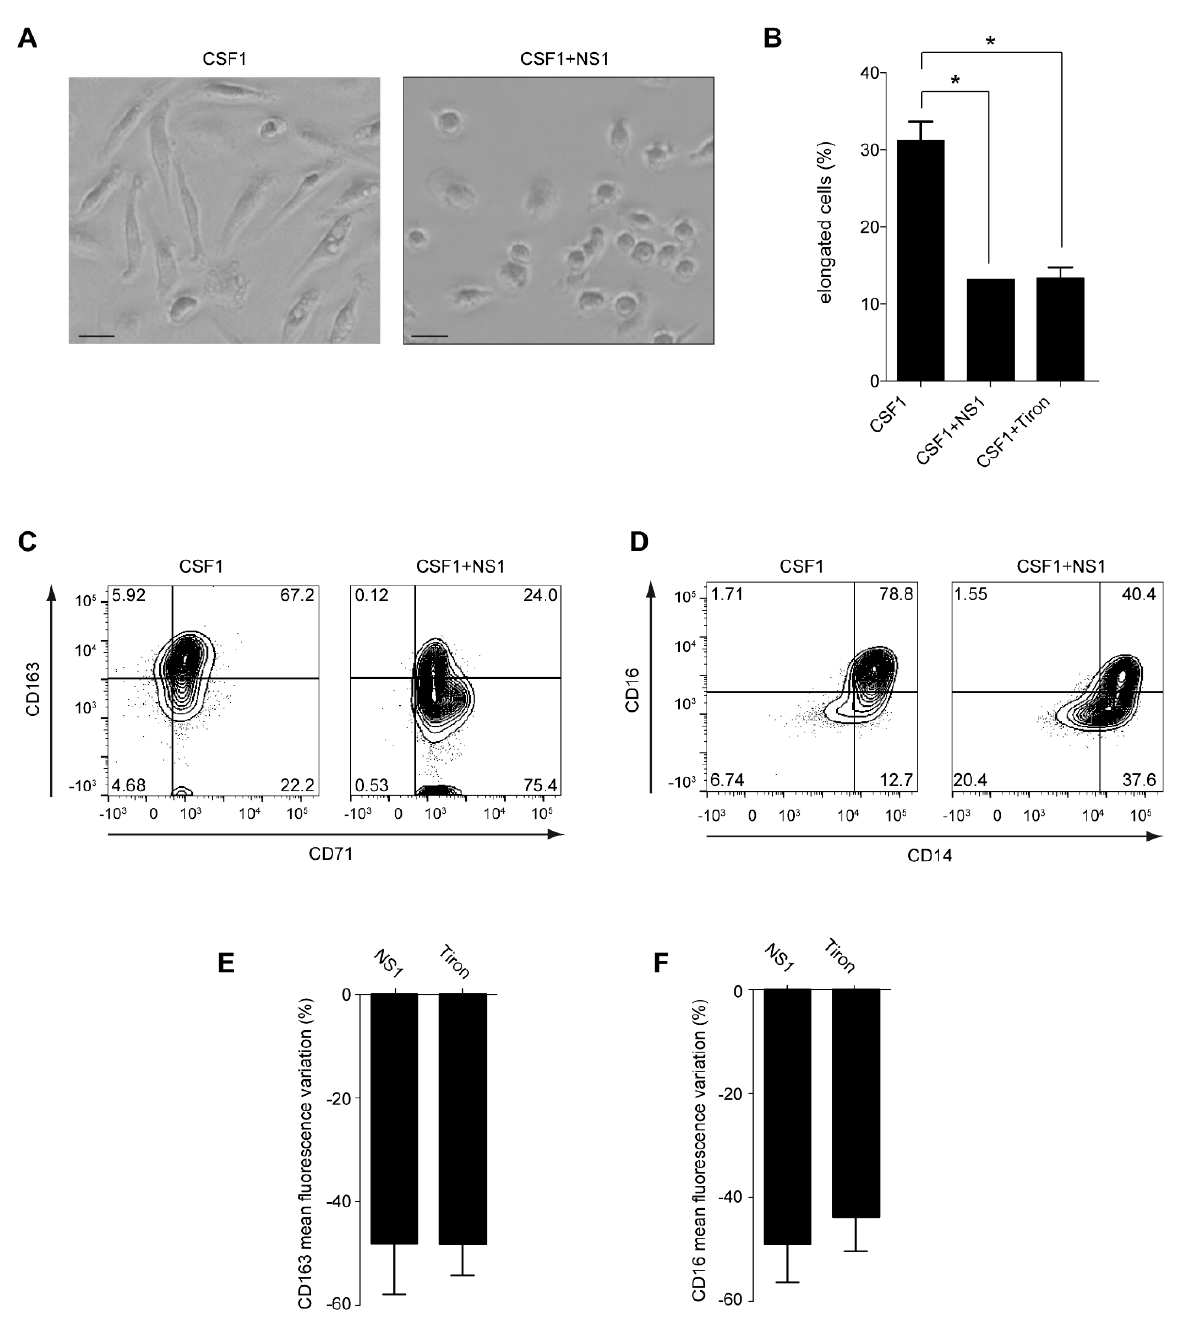
Figure 1. NS1 modifies macrophage differentiation . Monocytes from healthy donors were treated with CSF-1 (100 ng/mL, 3 days) in the absence or presence of NS1 (15 µ M) or Tiron (500 µ M). ( A ): Human CD14 + monocytes treated with CSF1 become adherent and elongated (left panel), a phenotype not observed after co-treatment with NS1 (right panel, scale 20 µ m). ( B ): The fraction of cells with an elongated shape (elongation factor > 2.5) was measured in monocytes treated with CSF1, CSF1 + NS1, CSF1 + Tiron. Fisher test with Bonferroni correction. *: p ≤ 5 × 10 − 2 ( C , D ): Cytometric analysis of surface markers CD71 and CD163 ( C ) or CD14 and CD16 ( D ) of monocytes + CSF1 ± NS1. ( E , F ): Variation in the Mean fluorescence index of cell surface CD163 ( E ) and CD16 ( F ) expression in monocytes treated with CSF1, CSF1+ NS1, CSF1 + Tiron compared to monocytes treated with CSF1.